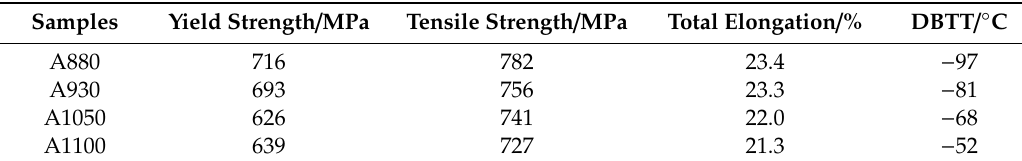
Table 1. Mechanical properties of experimental steel samples.